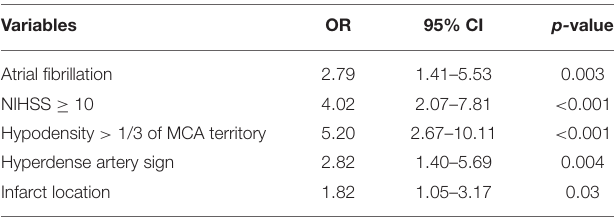
TABLE 3 | Multivariate analysis to identify independent predictors of spontaneous hemorrhagic transformation in the derivation cohort. Variables